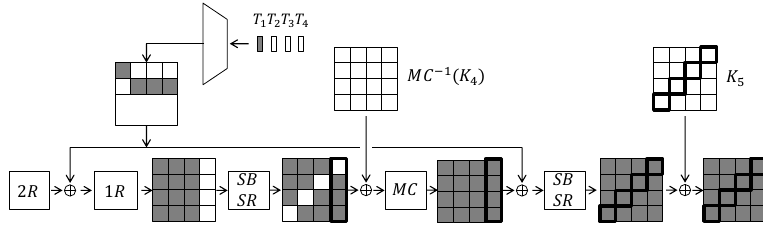
Figure 7: TweAES : 5-round Truncated Differential Attack using Tweak Difference (type